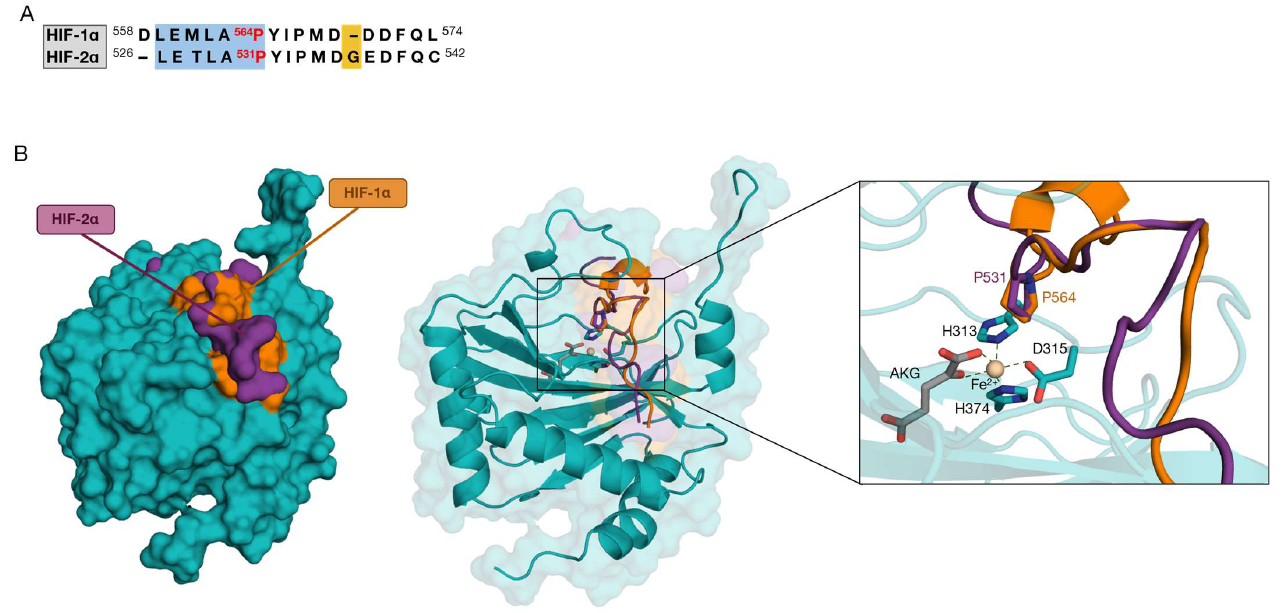
Figure 2. Sequence alignment and homology modeling of HIF-2α. ( A ) Sequence alignment between the 17 amino acid residues of HIF-1α (558–574) and HIF-2α (526–542). In red, the hydroxyl acceptor proline. LxxLAP motifs are shown in the light blue box. In yellow, the presence of glycine in HIF-2α leads to the formation of a gap in the HIF-1α sequence. ( B ) The left image shows the surfaces of the PHD2 complex (teal), with the HIF-1α (orange)/HIF-2α (purple) superposed. The right box shows the catalytic site and the conserved HIF-2α Pro531 position.